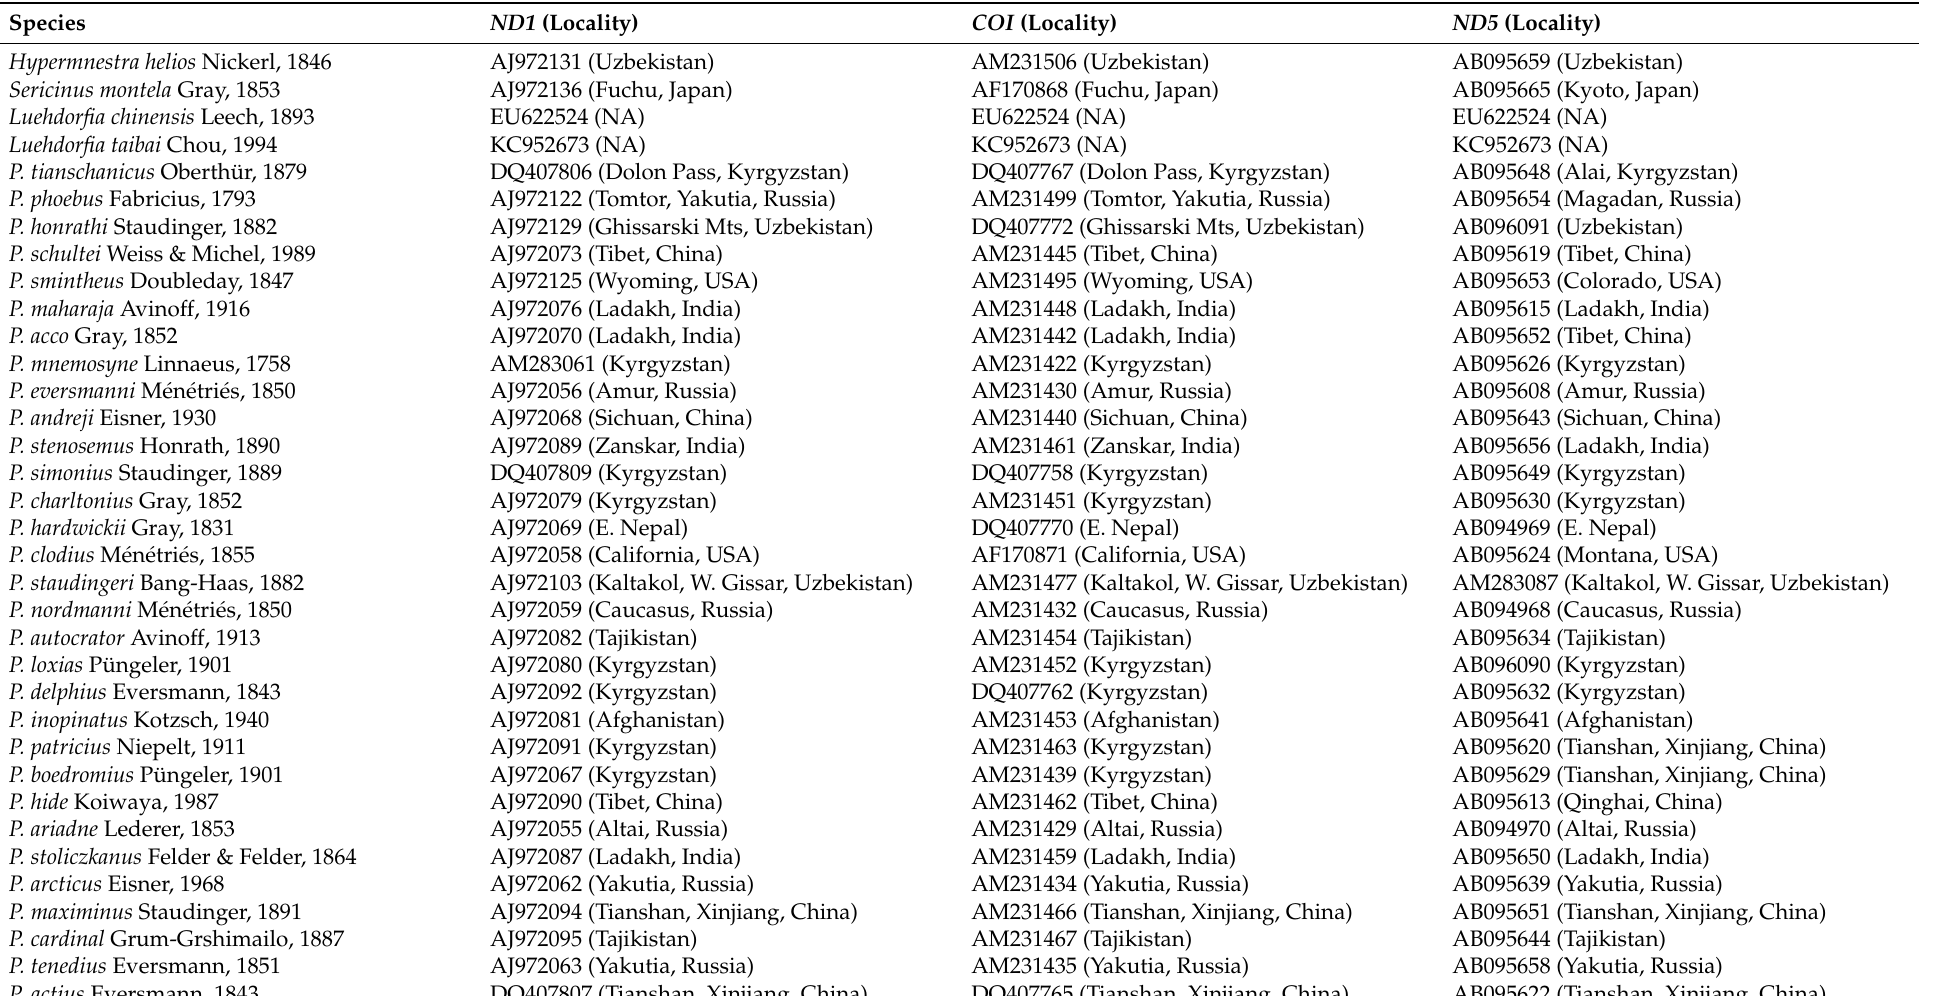
Table 1. General information regarding the mitochondrial sequences of 45 Parnassius and 4 outgroup species. Details of the samples collected for this study are presented in Table